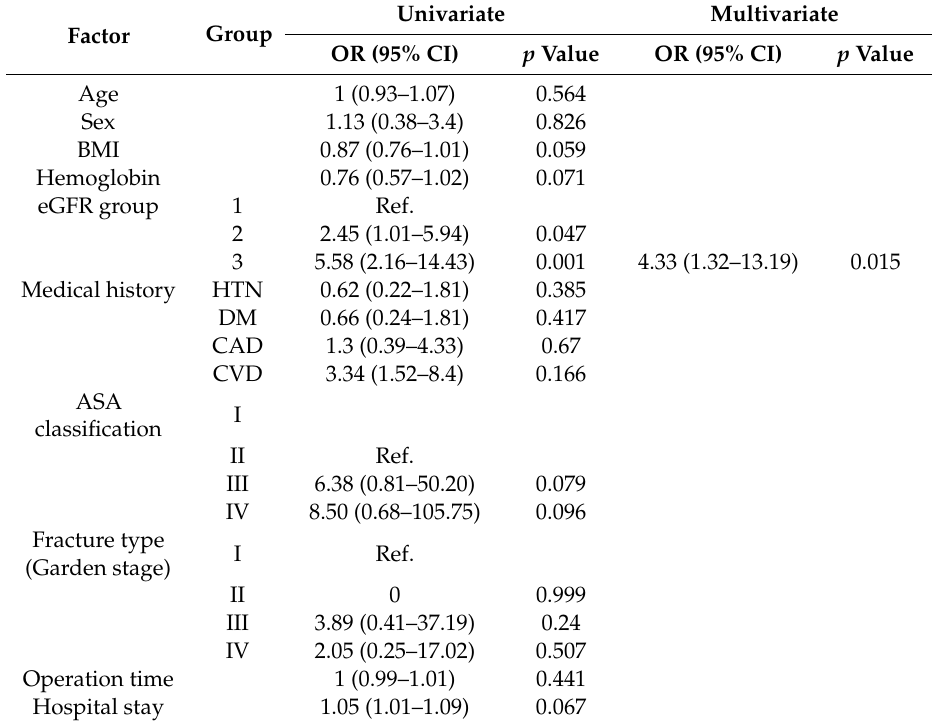
Table 5. Risk factors for surgical and medical